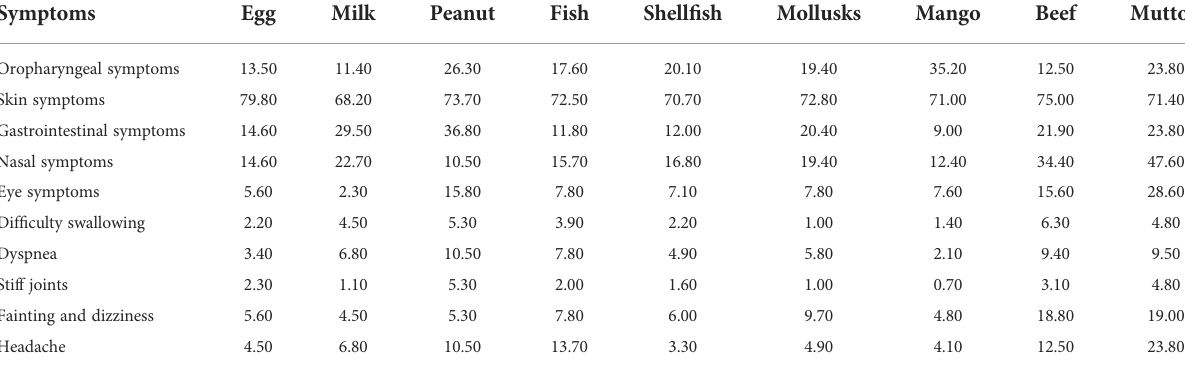
TABLE 4 The prevalence of main clinical symptoms associated with major allergenic foods (%).